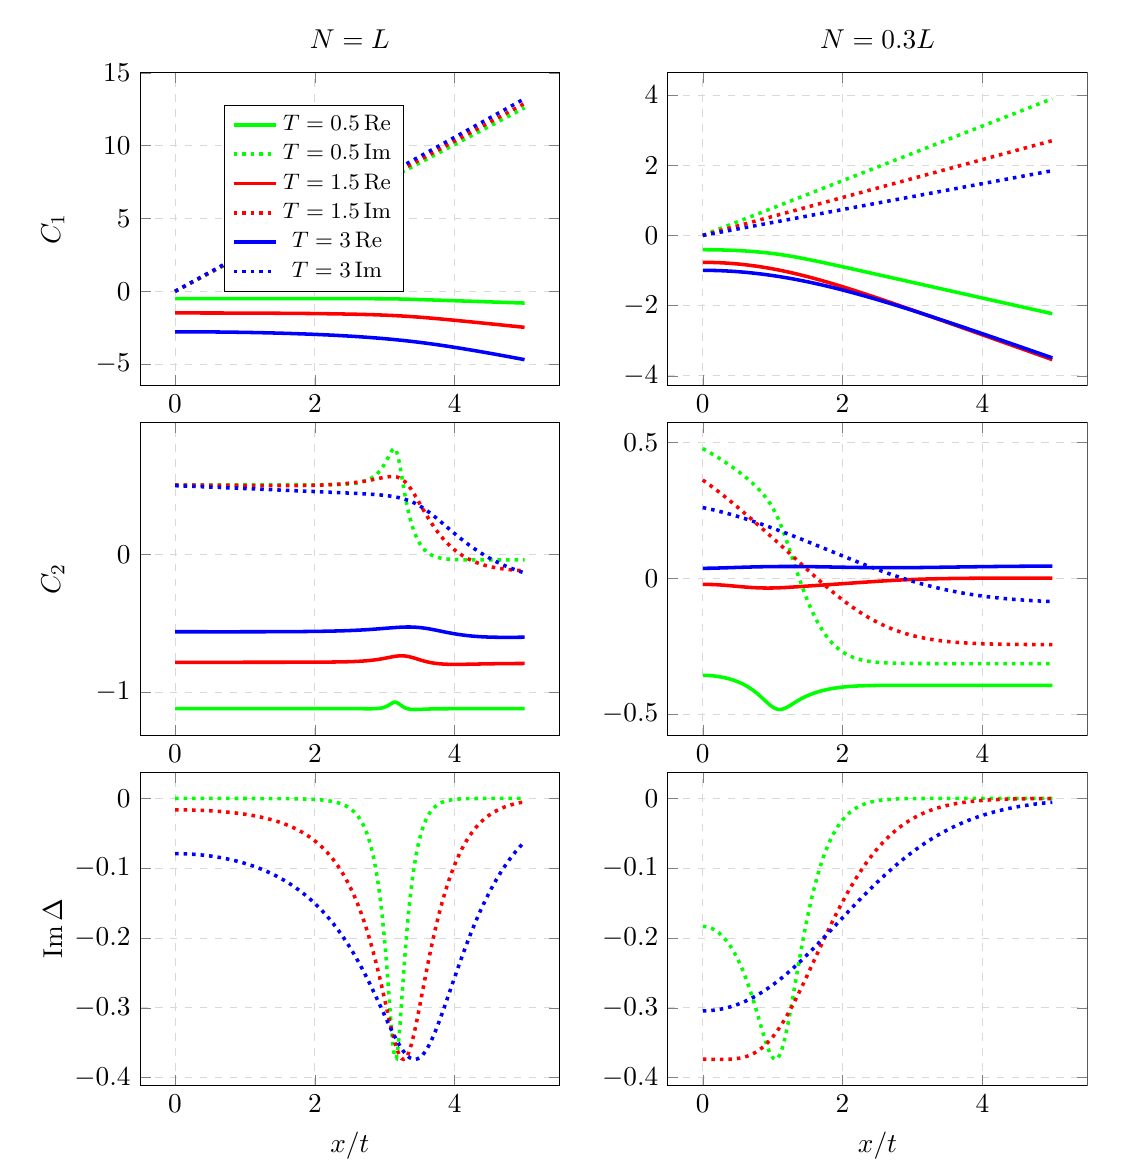
Figure 13: The Constants C and C , as defined in (150), as well as discontinuity 1 2 size ∆ from (118) are useful to estimate the τ -function, according to (151). These quantities are plotted against speed x / t , for the thermal distribution (23) at different temperatures T ∈ { 0.5,1.5,3 } . The left column has unit density, the right, N / L = 0.3. The shift ν = 0.4. Re ∆ = 0, which is not